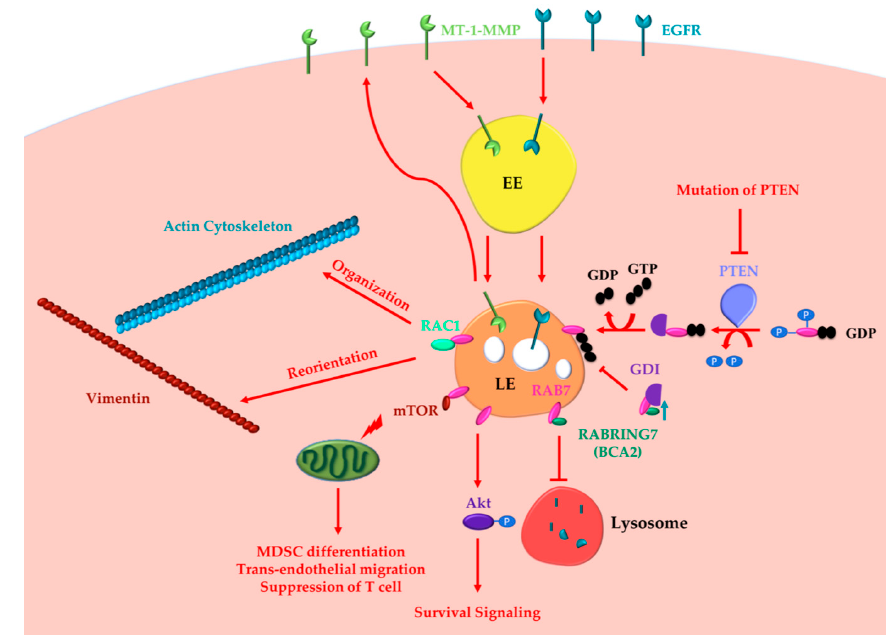
Figure 1. RAB7 (Ras-related in brain 7) oncogenic functions in cancer progression. RAB7A determines